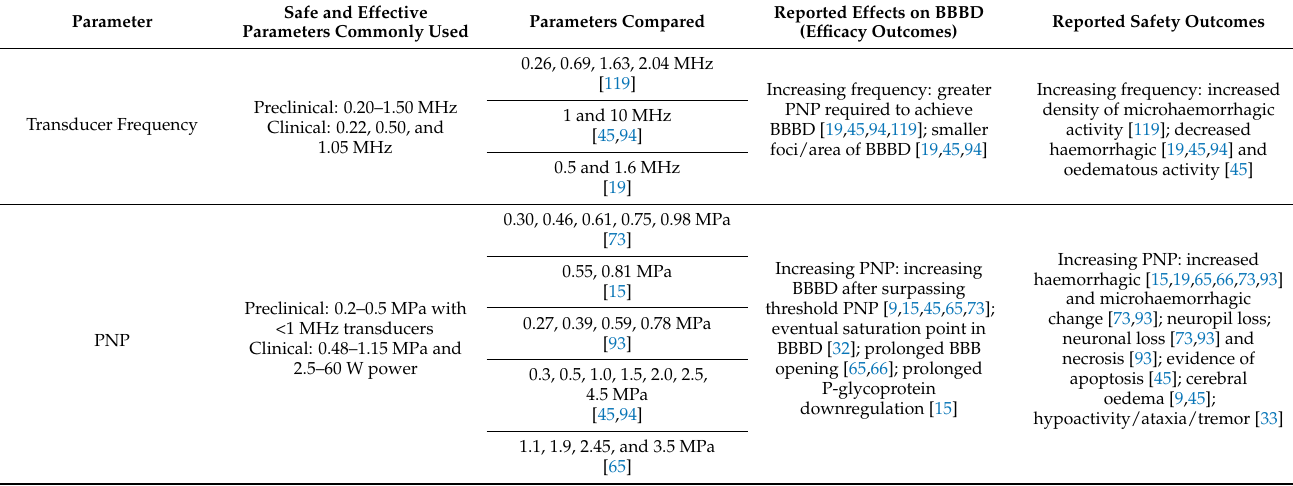
Table 4. Summary of safe and effective parameters used in identified studies and reported relation- ships between parameter escalation and BBB disruption efficacy and safety outcomes. Safe and Effective Parameters Commonly